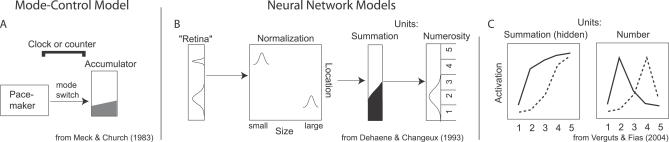
Models of Numerical Estimation Rely on an Accumulator Stage(A) In the mode-control model [31], an “accumulator” receives pulses from a pacemaker and stores an analog magnitude proportional to the quantity of stimuli enumerated. The accumulator value can represent elapsed time or quantity depending on the mode in which pulses are gated to it.(B) In the Dehaene and Changeux neural network model [32], “summation units” accumulate in parallel to the quantity of stimuli. This information is used by “numerosity” units, which represent the cardinal value of the set of stimuli.(C) The neural network model by Verguts and Fias [33] utilizes a hidden “summation” layer in which numerosity is represented in a monotonic fashion. Cardinal number is derived from summation units by “number” units.